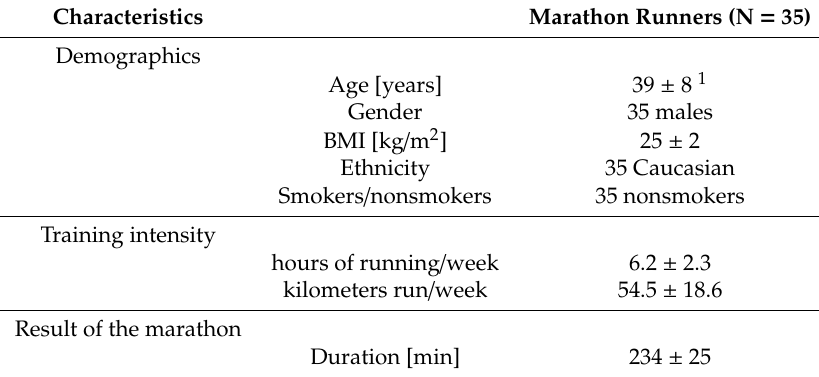
Table 1. Demographics, training intensity and results of the marathon run in the studied